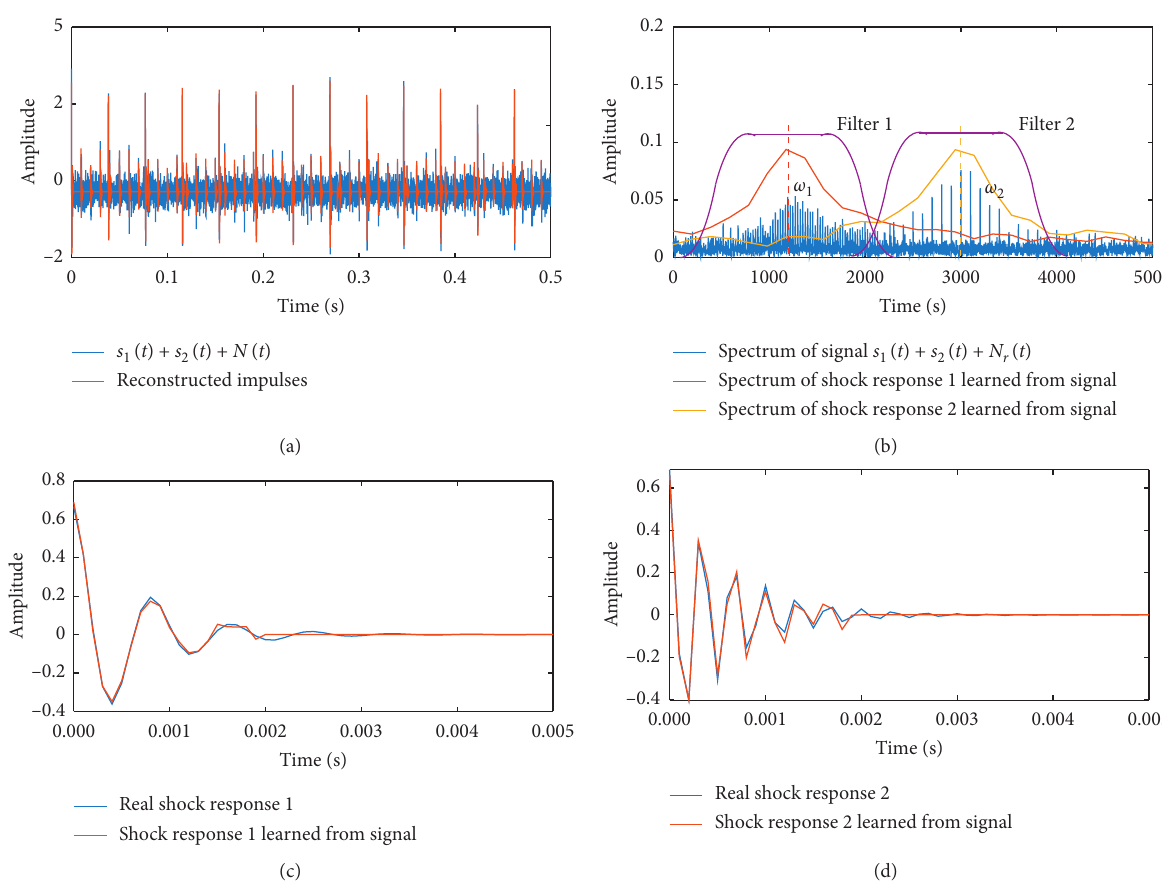
Figure 9: (a) The simulation signal (blue line) and sparse reconstruction signal (red line); (b) the spectrums of simulation signal, shock response 1 and shock response 2; (c) shock response 1 learned from signal; and (d) shock response 2 learned from